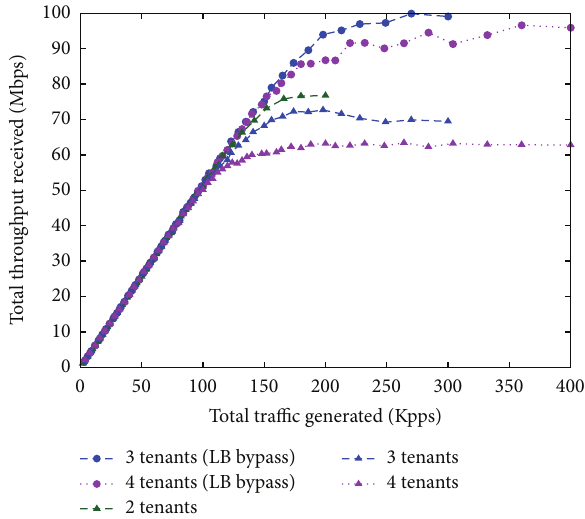
Figure 15: Total throughput measured versus total packet rate generated by 2 to 4 tenants for 64 -byte packet size. Comparison between normal OpenStack mode and Linux Bridge bypass with 3 and 4 tenants.